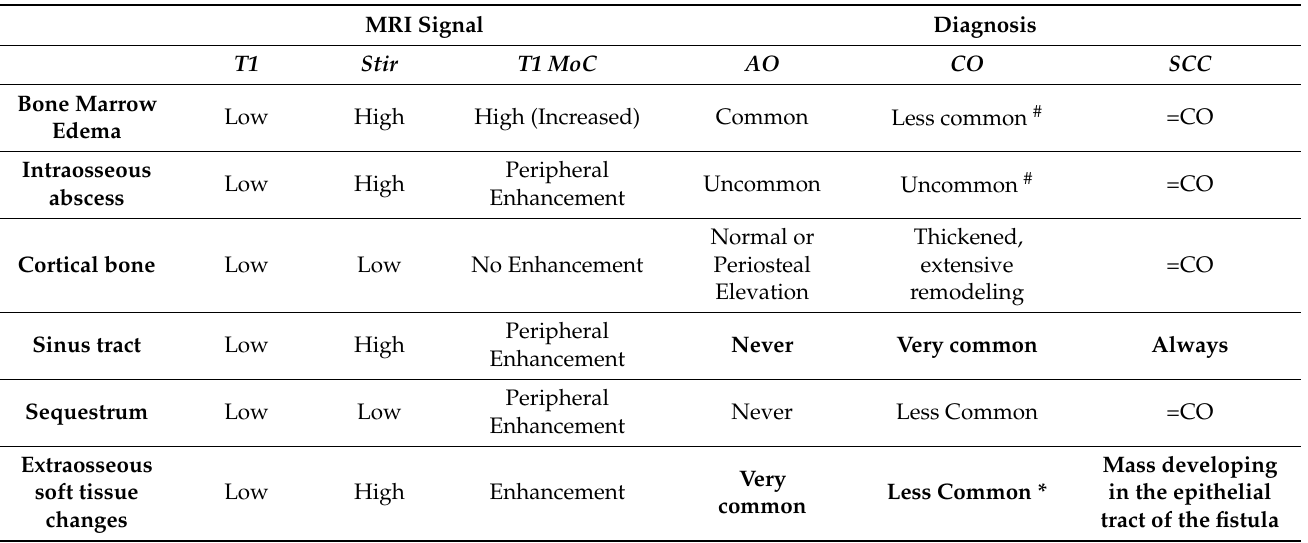
Table 1. General MRI features of acute osteomyelitis (AO), chronic osteomyelitis (CO) and spinocel- lular carcinoma (SCC): evidence of the main features in differential